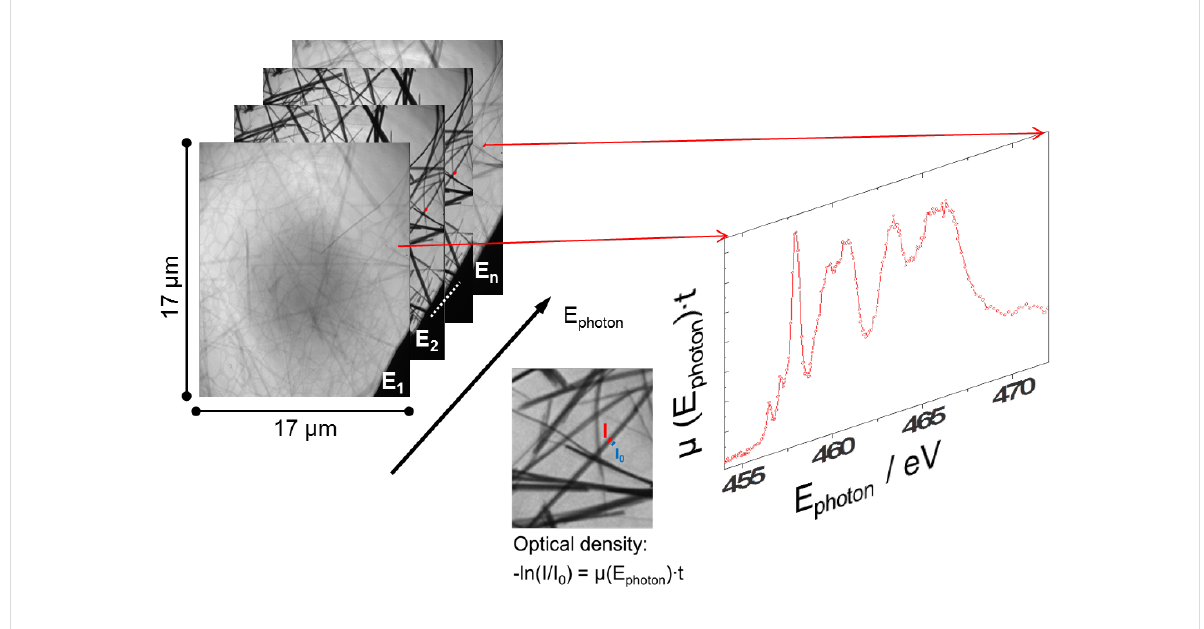
Figure 7: Workflow for NEXAFS-TXM: A data set of images at different photon energies is taken with the HZB-TXM. A NEXAFS spectrum can be generated out of this data set by using defined areas of the sample to measure I ( E ) and neighbouring blank areas for I 0 ( E )